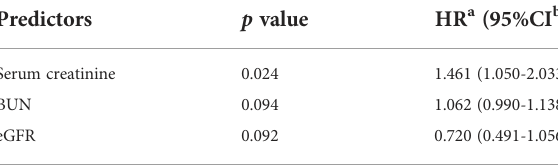
TABLE 4 Multivariable predictors of death in DPPs by multivariate COX regression